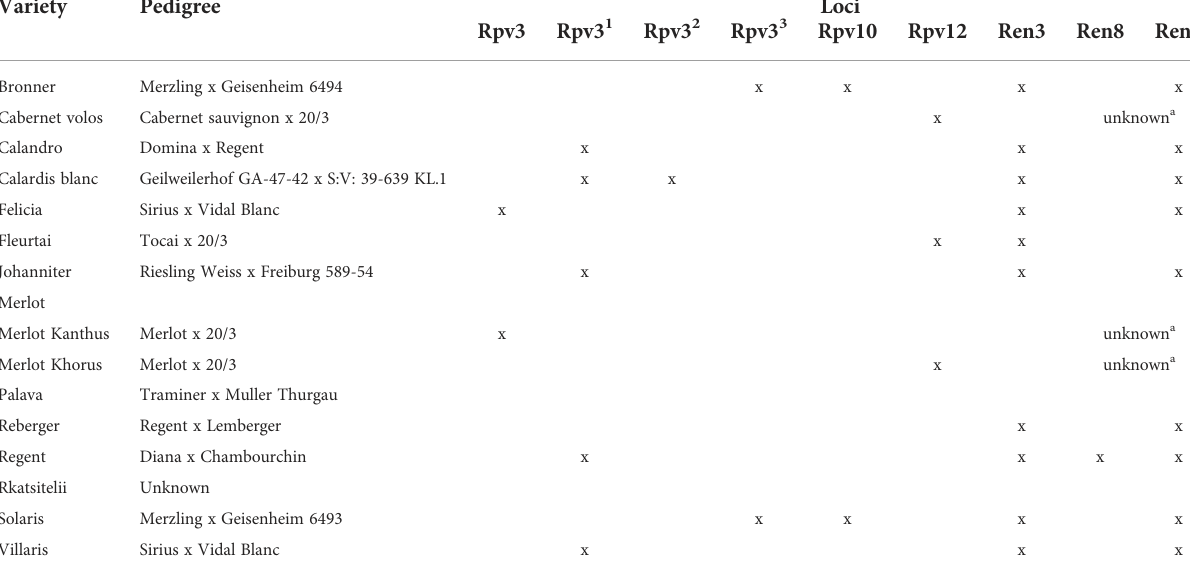
TABLE 1 The 16 varieties used in the study, their pedigrees, and their resistance-related loci to Plasmopara viticola (Rpv) and Erysiphe necator (Ren). Variety